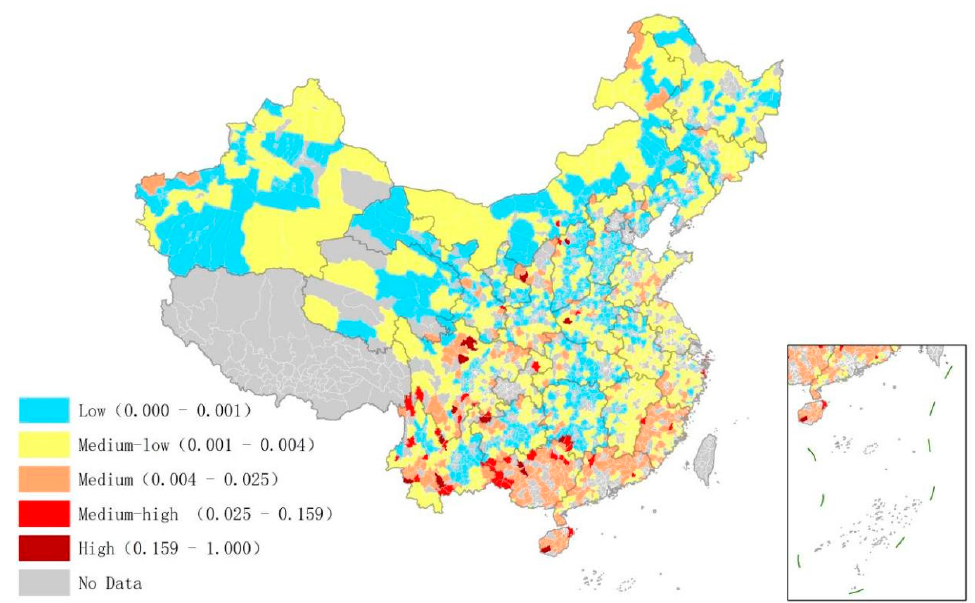
Figure 2. Low-carbon management efficiency of the housing sector in Chinese counties.